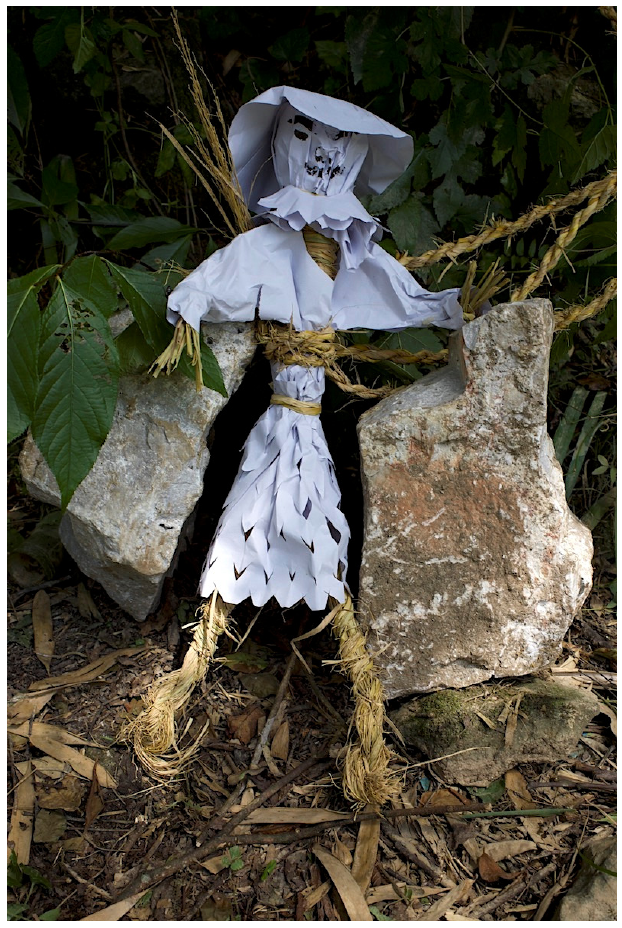
Figure 14. The Doll Ghost, which is performed in nearby woods. (Photo: Thomas Riccio).